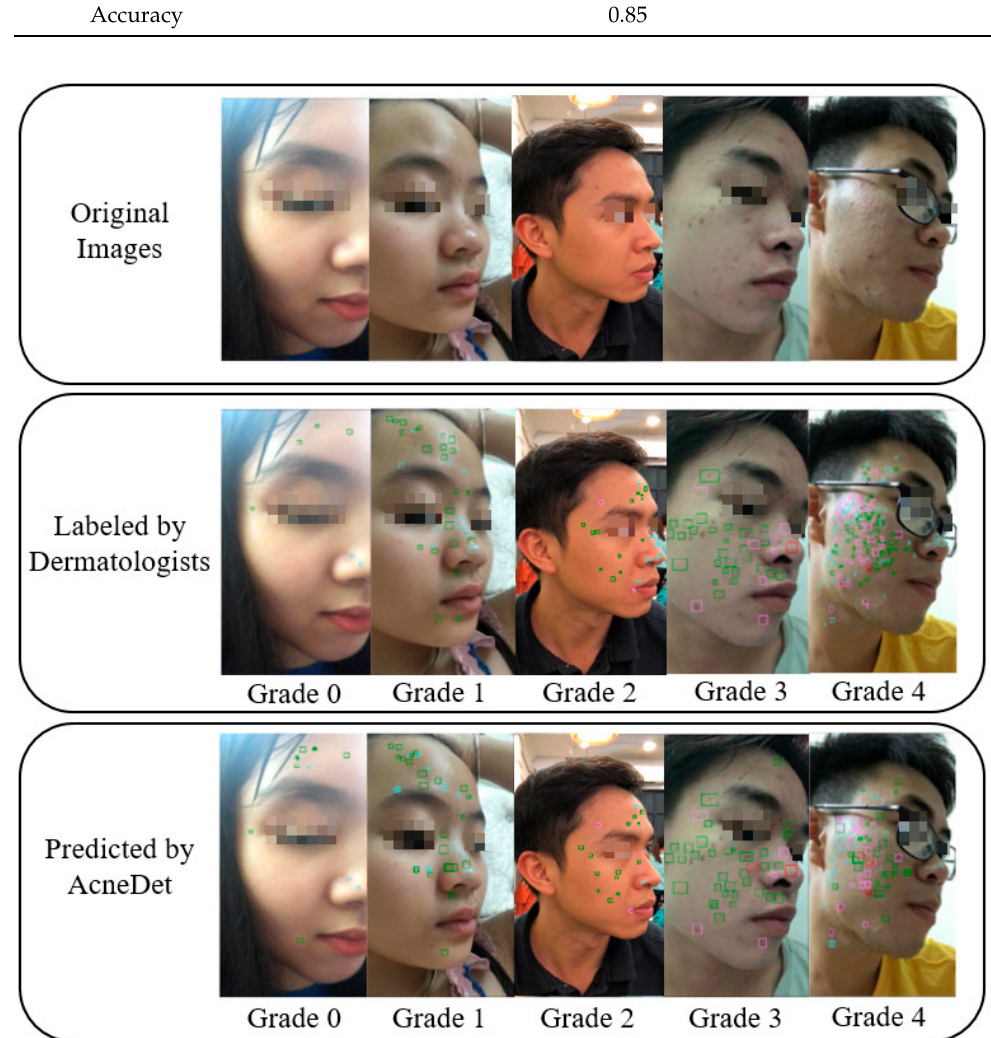
Figure 7. Comparison of predictions by AcneDet with ground truths labeled by dermatologists.